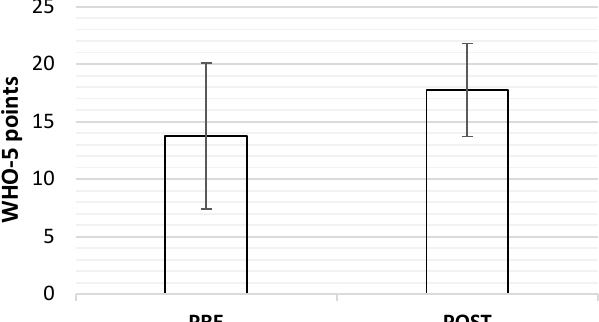
Figure 5. Difference in subjective assessment of participants’ well-being before (PRE) and after (POST) the intervention presented as averages with standard deviation. Statistically significant difference p < 0.01; d = 0.76.